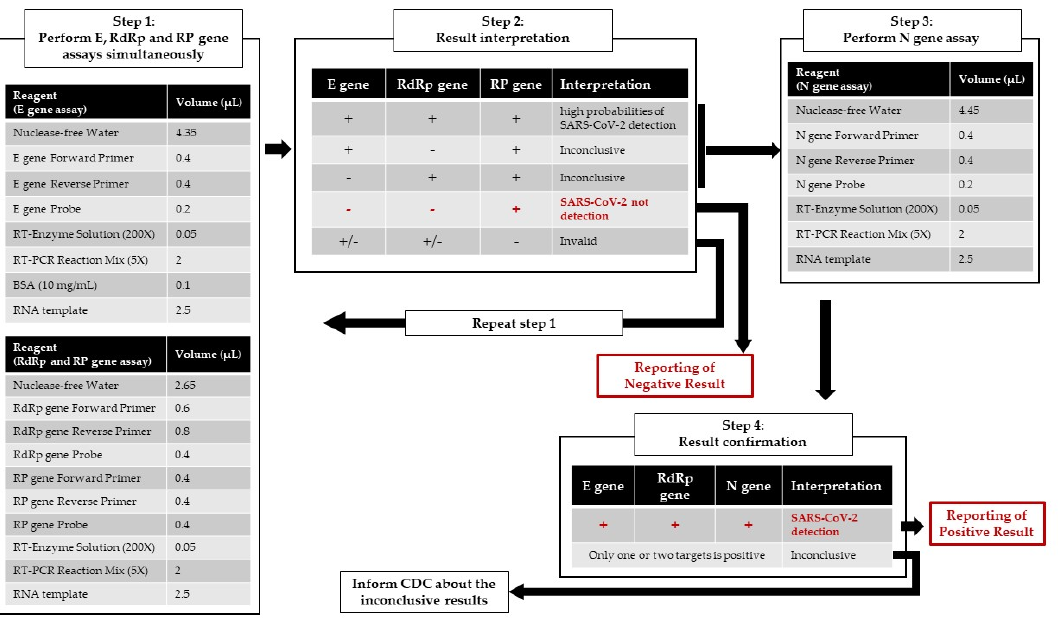
Figure 4. Flowchart of the optimized COVID-19 molecular diagnostic workflow protocol in the laboratory at the Kaohsiung Medical University Hospital.